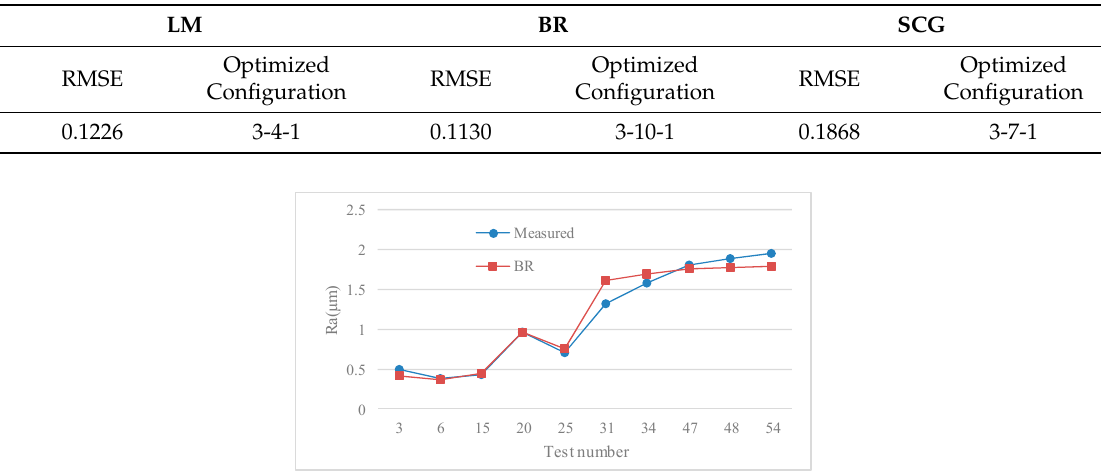
Figure 9. BR prediction results.